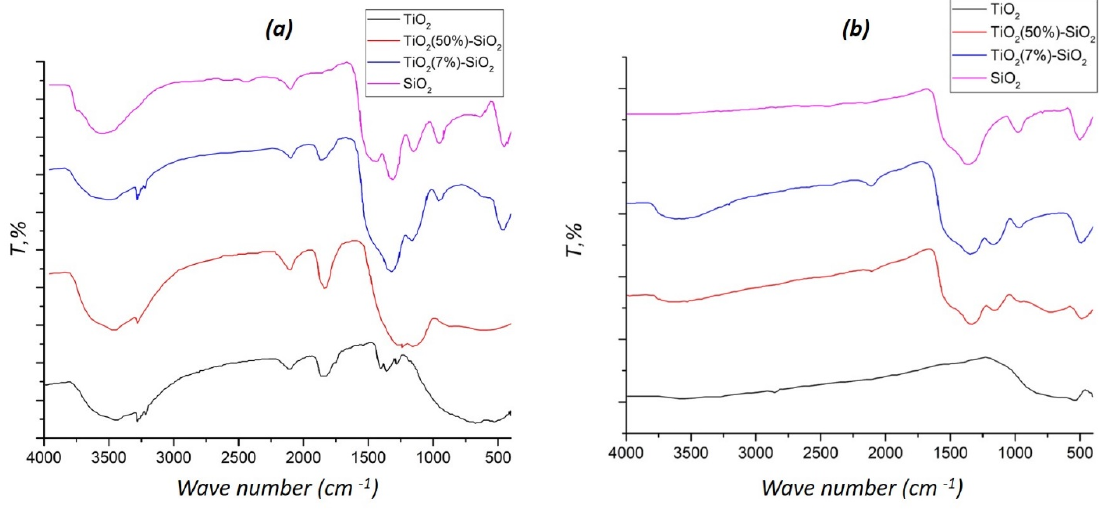
Figure 2. FT-IR spectra of synthesized xerogels ( a ) before and ( b ) after annealing at 850 °C. The complex-shaped band corresponded to asymmetric stretching vibrations and the average intensity band at 798 cm − 1 to symmetric stretching vibrations of SiO 4 tetrahedra. The absorption band with a maximum at 945 cm − 1 demonstrated symmetric stretching vibrations of nonbridging Si–O– bonds. An intense band at 435 cm –1 corresponded to the bending vibrations of polyhedra. The absorption bands of stretching vibrations of surface hydroxyl groups and water appeared to be in the range of 3700–3000 cm –1 . A broadband of average intensity in the region of 1626 cm − 1 corresponded to the bending vibrations of water [29]. The ratios of the intensities of the absorption bands of Ti–O–Si and Si–O–Si groups at 950 cm –1 and 1079 cm –1 , respectively, for binary oxide xerogels as a